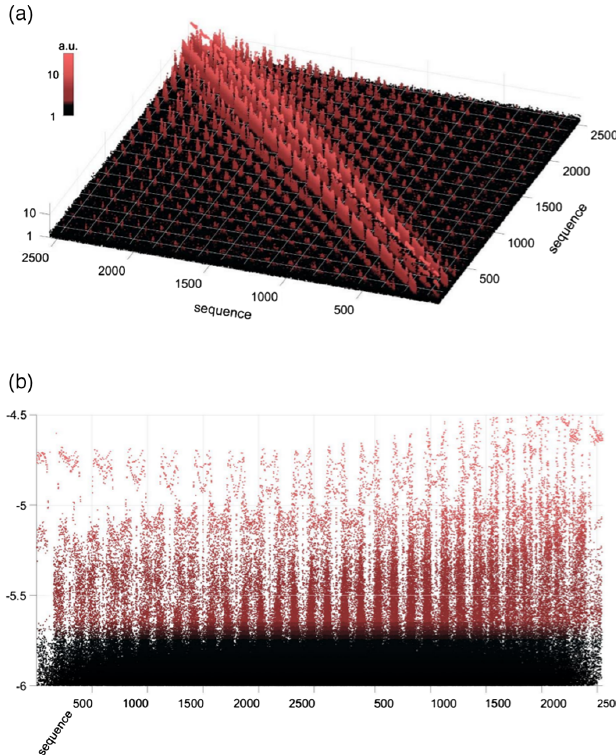
FIG. 5. Long-range genetic correlations. (a) The sequence correlation matrix across the 10 6 examples shows long-range correlations among the bits (codons) at the rigid or fluid boundary, and short-range correlations in the rigid domains. (b) A cross section perpendicular to the diagonal